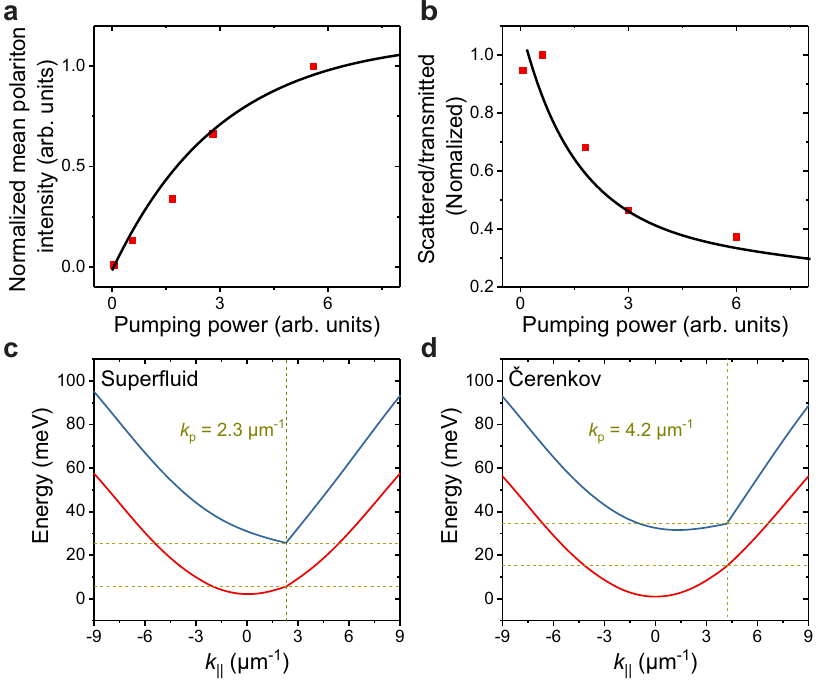
Fig. 5 | Power-dependence of the super fl uidity and simulated Bogoliubov excitation spectra of the lower polariton branch. a Mean polariton density (normalized) as a function of pumping power in the super fl uid regime. b Ratio of scatteredlighttotransmittedlight(normalized)asafunctionofpumpingpowerin the super fl uidity regime. The experimental data (red solid points) are obtained fromthescatteringringinFig.4c-III,c-IVandSupplementaryFig.9.Theblacksolid lines are the simulated results in both a and b . c Positive Bogoliubov excitation spectracorrespondtothesuper fl uiditycaseinFig.and4c,dwith k p =2.3 μ m − 1 .The red and blue solid lines correspond to the low and high pumping power cases, respectively. Bogoliubov excitation spectra are a good model even for the fs-laser pumping cases, as previously demonstrated 12,24 . Here the super fl uidity regime was analyzed. At low pumping power, the dispersion shows a parabolic shape, and the injectedpolaritoncanbeelasticallyscatteredtothesameenergystatesasindicated by the yellow dashed lines. At high pumping power, the polariton-polariton